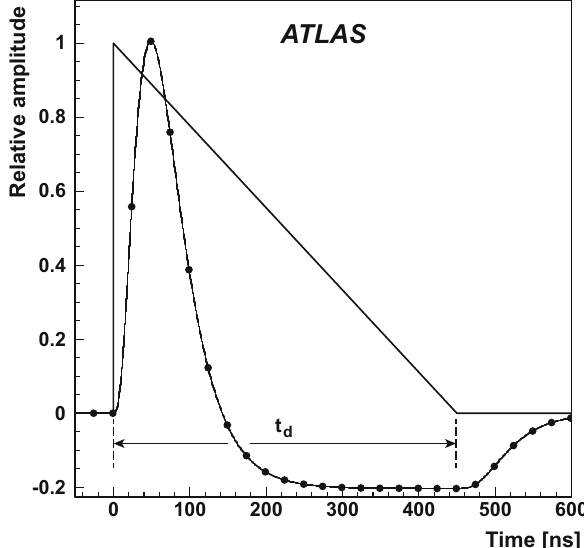
Fig. 3 The pulse shape in the ATLAS LAr calorimeters. The unipolar triangular pulse is the current pulse in the liquid argon generated by fast ionising particles. Its characteristic time is the drift time (charge collection time) t d , with t d ≈ 450ns in the example for the central EMB calorimeter shown here. The shaped pulse is superimposed, with a characteristic duration of τ signal ≈ 600ns. The full circles on the shaped pulse indicate the nominal bunch crossings at 25ns intervals. The figure has been adapted from Ref.